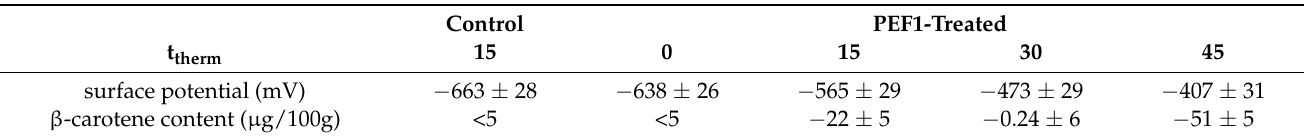
Table 1. Surface potential and β -carotene content of CM after different incubation times at 60 ◦ C (t therm ) with and without PEF1 treatment